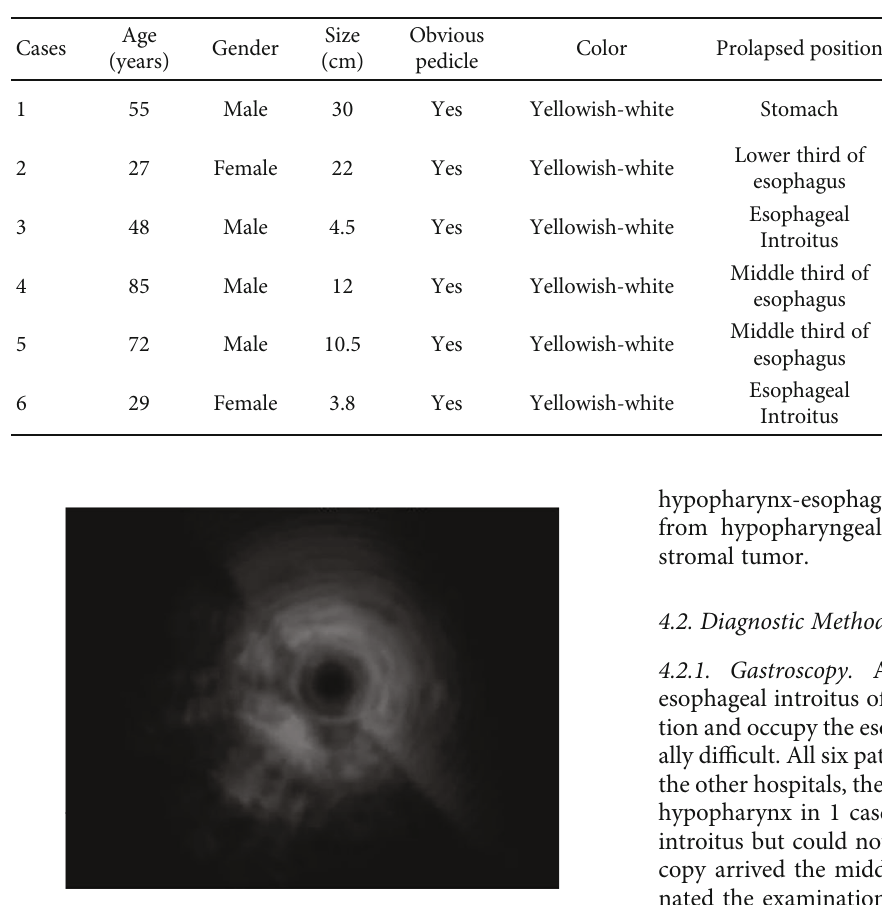
Table 1: Gastroscopic fi ndings.